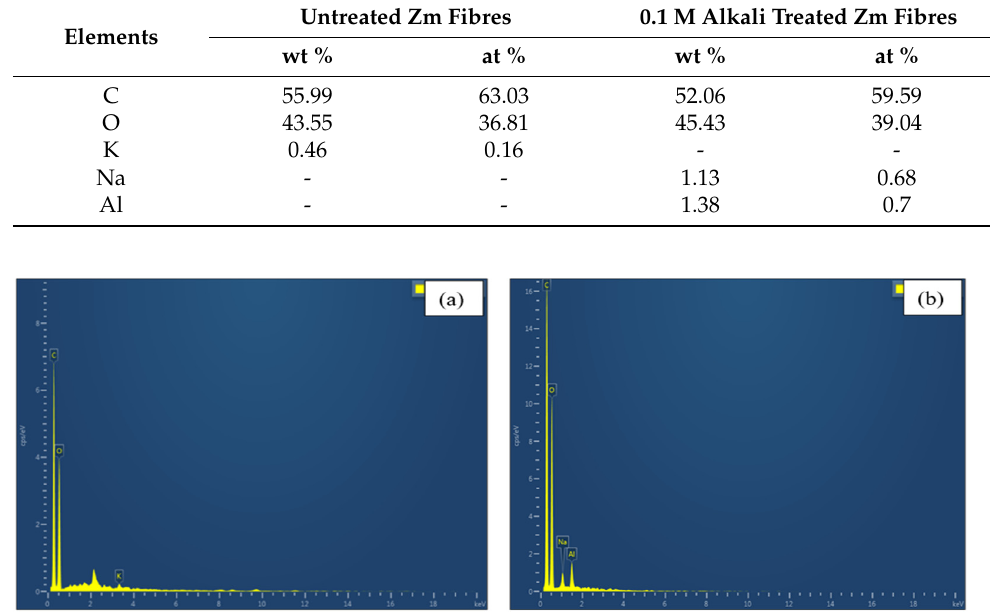
Figure 8. EDAX spectrum: ( a ) Untreated Zm fi bres; ( b ) Alkali treated Zm fi bres.